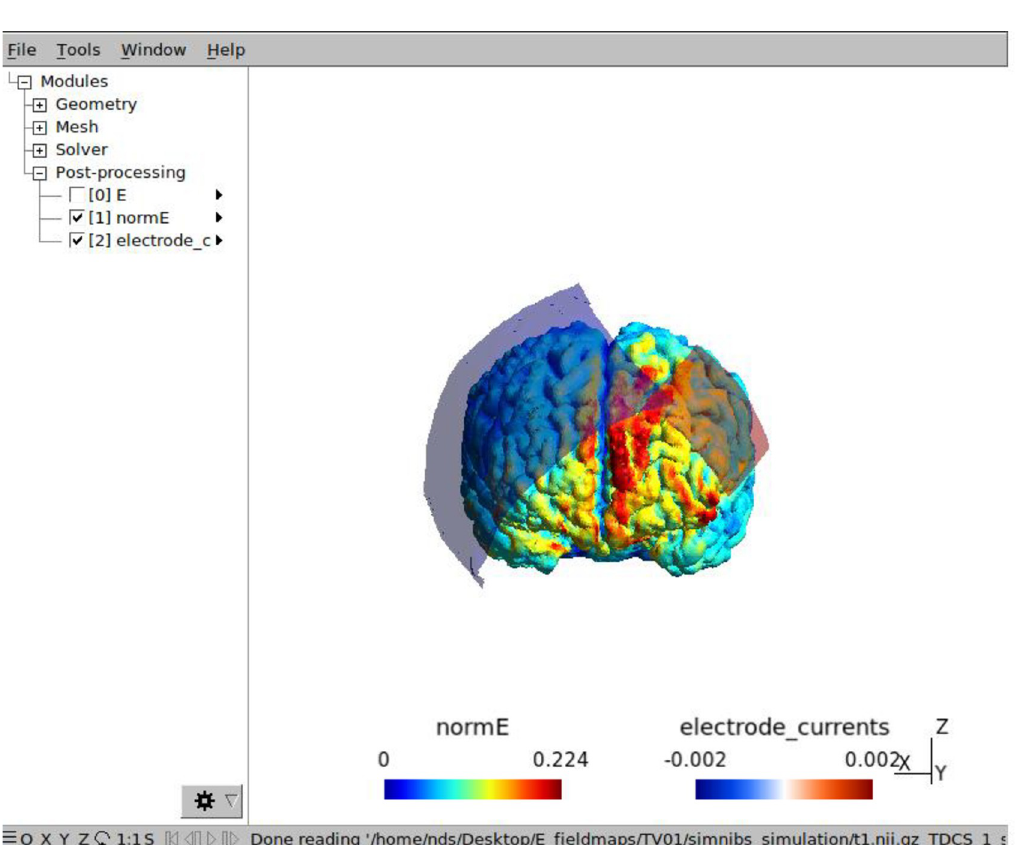
Fig 3. Estimated electrical field for tDCS stimulation (using